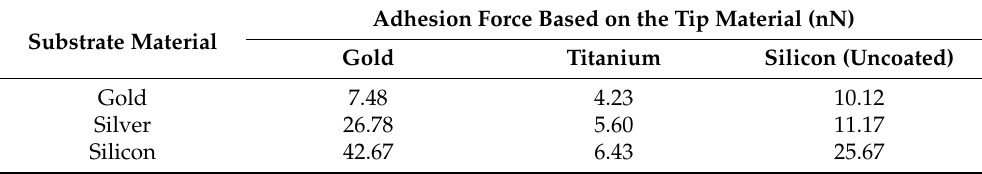
Table 2. Adhesion forces’ values of substrates obtained by various tip materials.